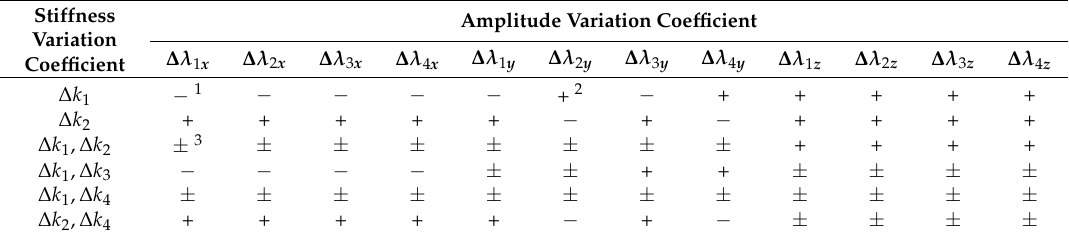
Table 3. The change rules between the spring stiffness coefficient and the amplitude variation coefficient.